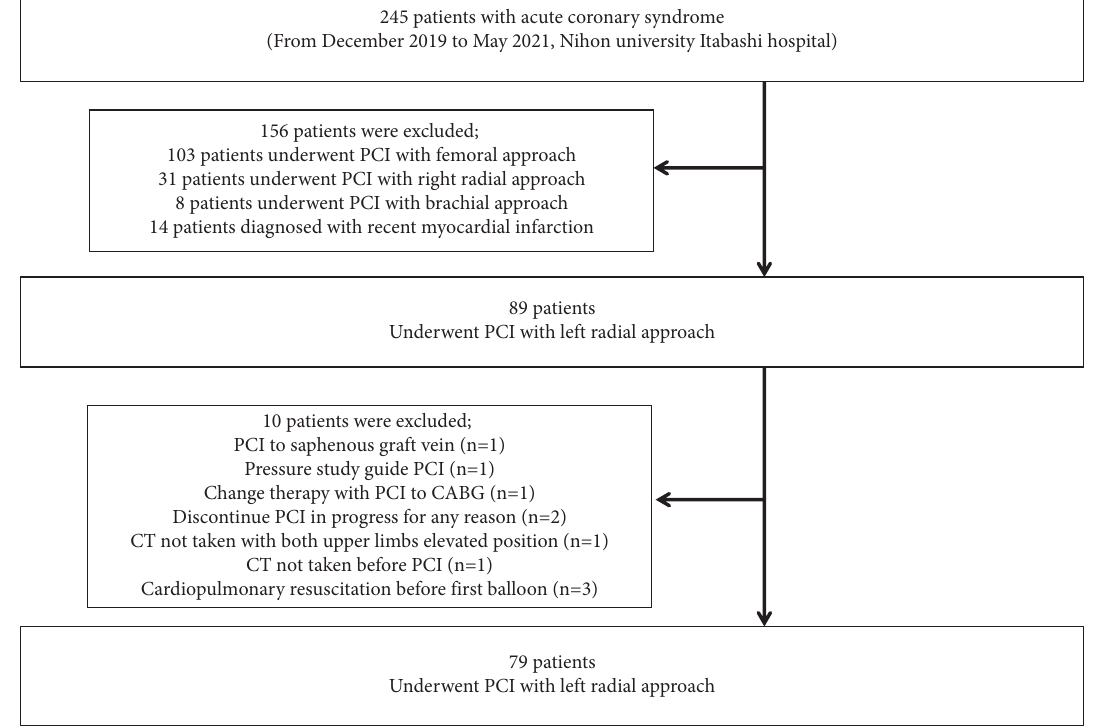
Figure 1: Study fow diagram. CABG, coronary artery bypass grafting; PCI, percutaneous coronary intervention.